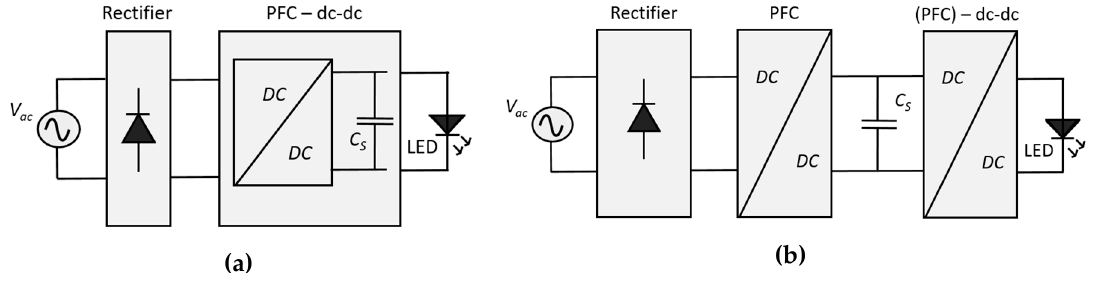
Figure 3. ( a ) SS switching LED driver topology. ( b ) TS switching LED driver topology.